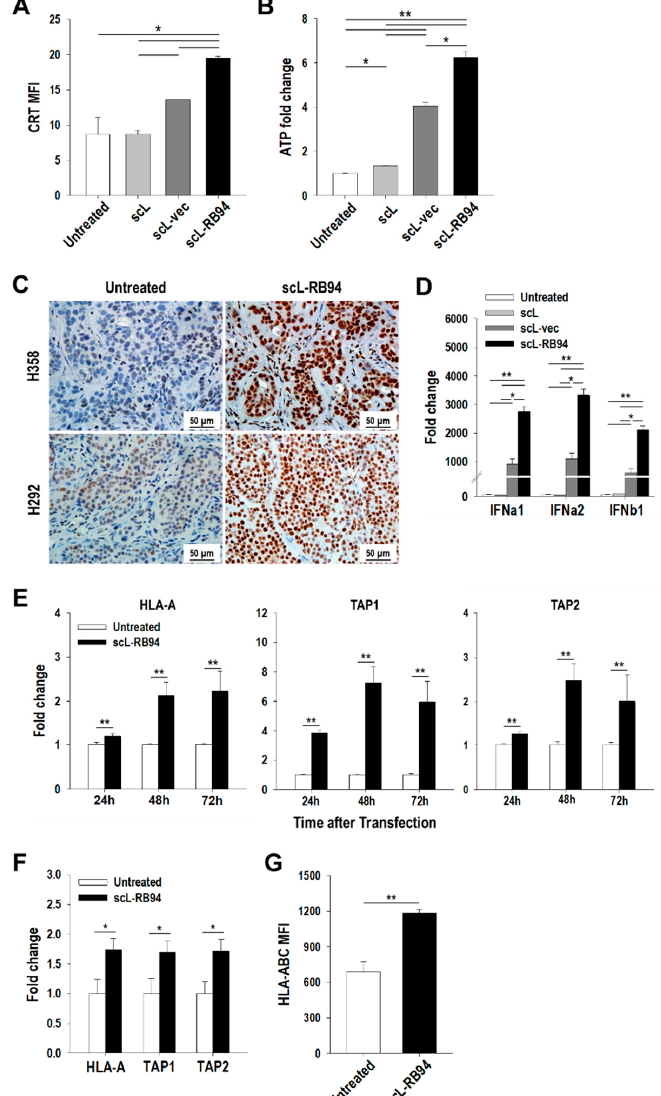
Figure 2. scL-RB94 increases immunogenicity of NSCLC cells. ( A ) Flow cytometry analysis of surface expression of CRT and ( B ) ATP concentration in cell culture supernatants in H358 cells after transfection with scL-RB94 nanocomplex in vitro. In the control, H358 cells were transfected with either scL-vec nanocomplex carrying the control plasmid vector without RB94 or empty scL nanocomplex without the payload. * p < 0.05, ** p < 0.001, one-way ANOVA. ( C ) Representative HMGB1 staining of H358 and H292 tumors 48 h after scL-RB94 treatments (30 µ g/injection/mouse, two injections over 3 days, N = 8). Quantitative RT-PCR analysis of ( D ) type I interferons and ( E , F ) antigen presentation and processing molecules, HLA-A, TAP1, and TAP2 in ( D , E ) H358 cells in vitro and ( F ) H358 tumors in vivo after treatment with scL-RB94. * p < 0.05, ** p < 0.001, one-way ANOVA or Student’s t test. ( G ) Flow cytometry analysis of expression of HLA-ABC in H358